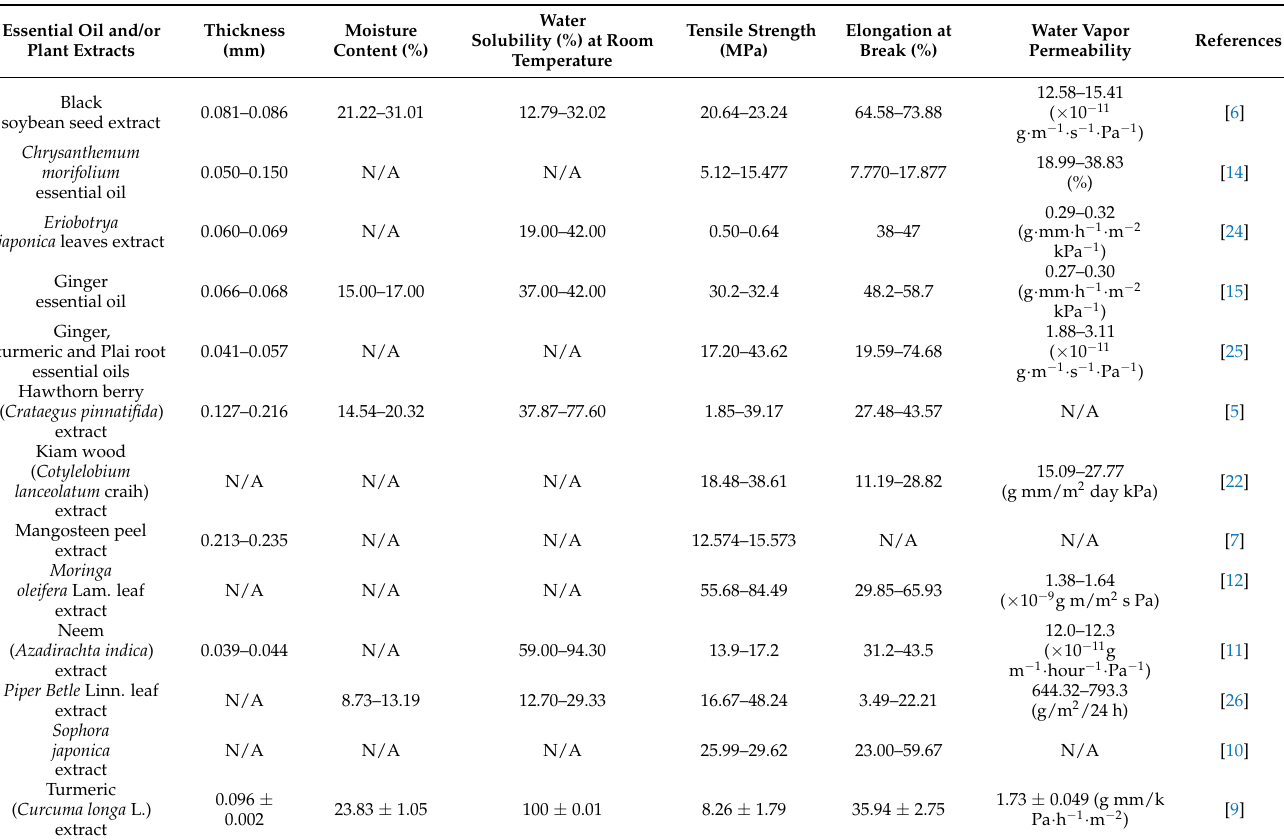
Table 2. Physicochemical and mechanical properties of EF incorporated with APE and